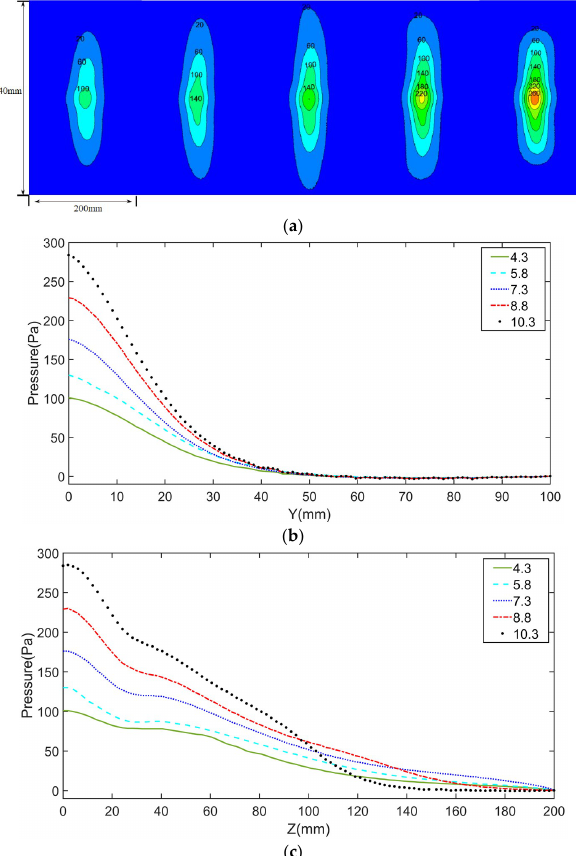
Figure 11. Pressure distribution on the target surface under different Δ: ( a ) pressure contour (Pa) (from left to right, Δ goes up); ( b ) pressure distribution curve along the y -axis; ( c ) pressure distribution curve along the z -axis.